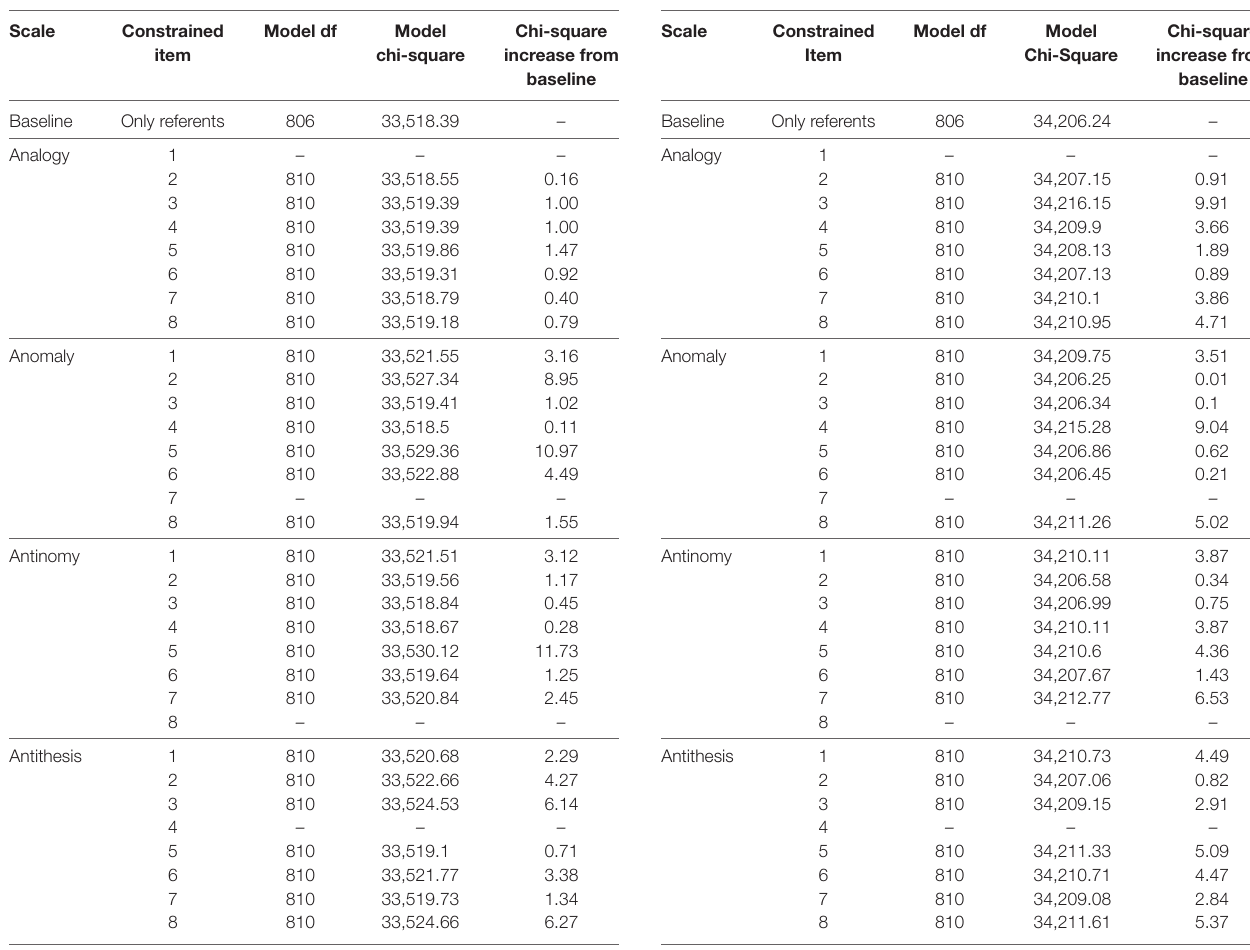
taBlE 8 | Likelihood-ratio tests for differential item functioning between white and Hispanic